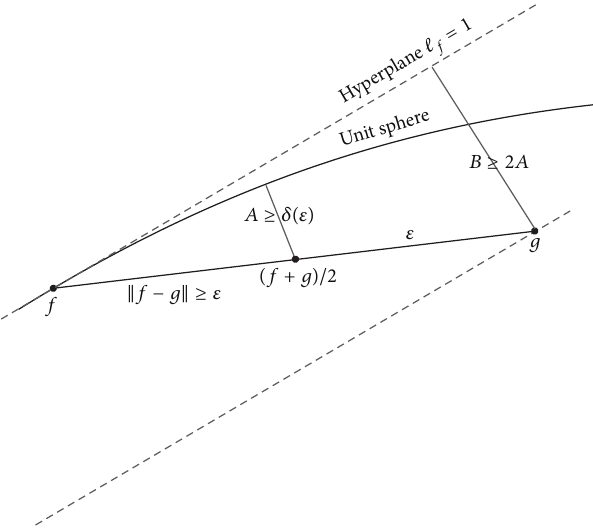
Figure 1: Estimate for ℓ 𝑓 (𝑔) if ‖𝑓 − 𝑔‖ ⩾ 𝜀 and 𝑓 has norm